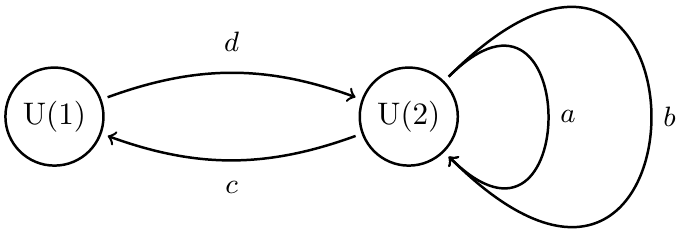
Figure 5 . Four-dimensional N = 1 quiver gauge theory for Laufer’s example with n =